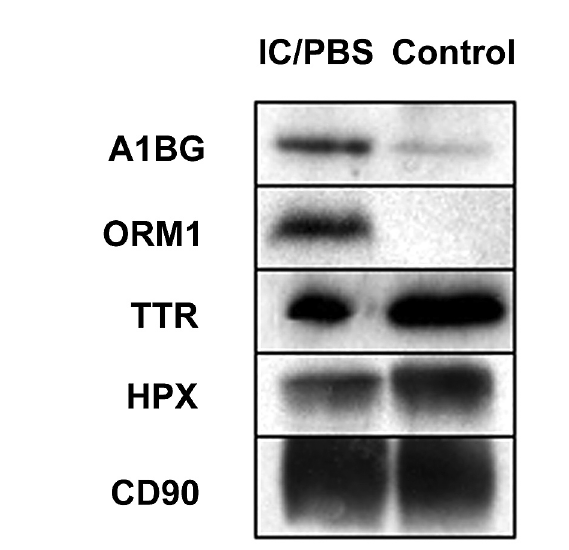
Figure 2 – Western blot analysis of differentially expressed pro- teins. Ten µg of pooled proteins were resolved by gel electropho - resis and probed by antibodies. The expression level as indicated by the band intensity correlated well with the spectral count quantification method. Shown are the results for α -1B-glycopro- tein (A1BG), orosomucoid-1 (ORM1), transthyretin (TTR), and hemopexin (HPX). CD90 (Thy-1) served as the control for sample loading. CD90 is a GPI-anchored protein also found